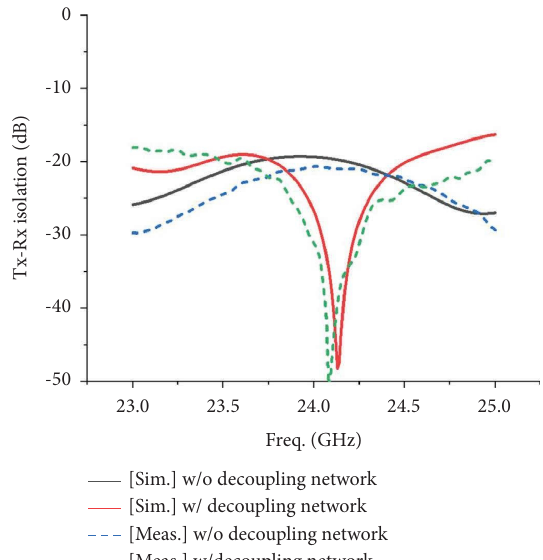
Figure 16: Tx to Rx isolations of the conventional Tx/Rx antennas without the decoupling network and the proposed ones with the decoupling network.